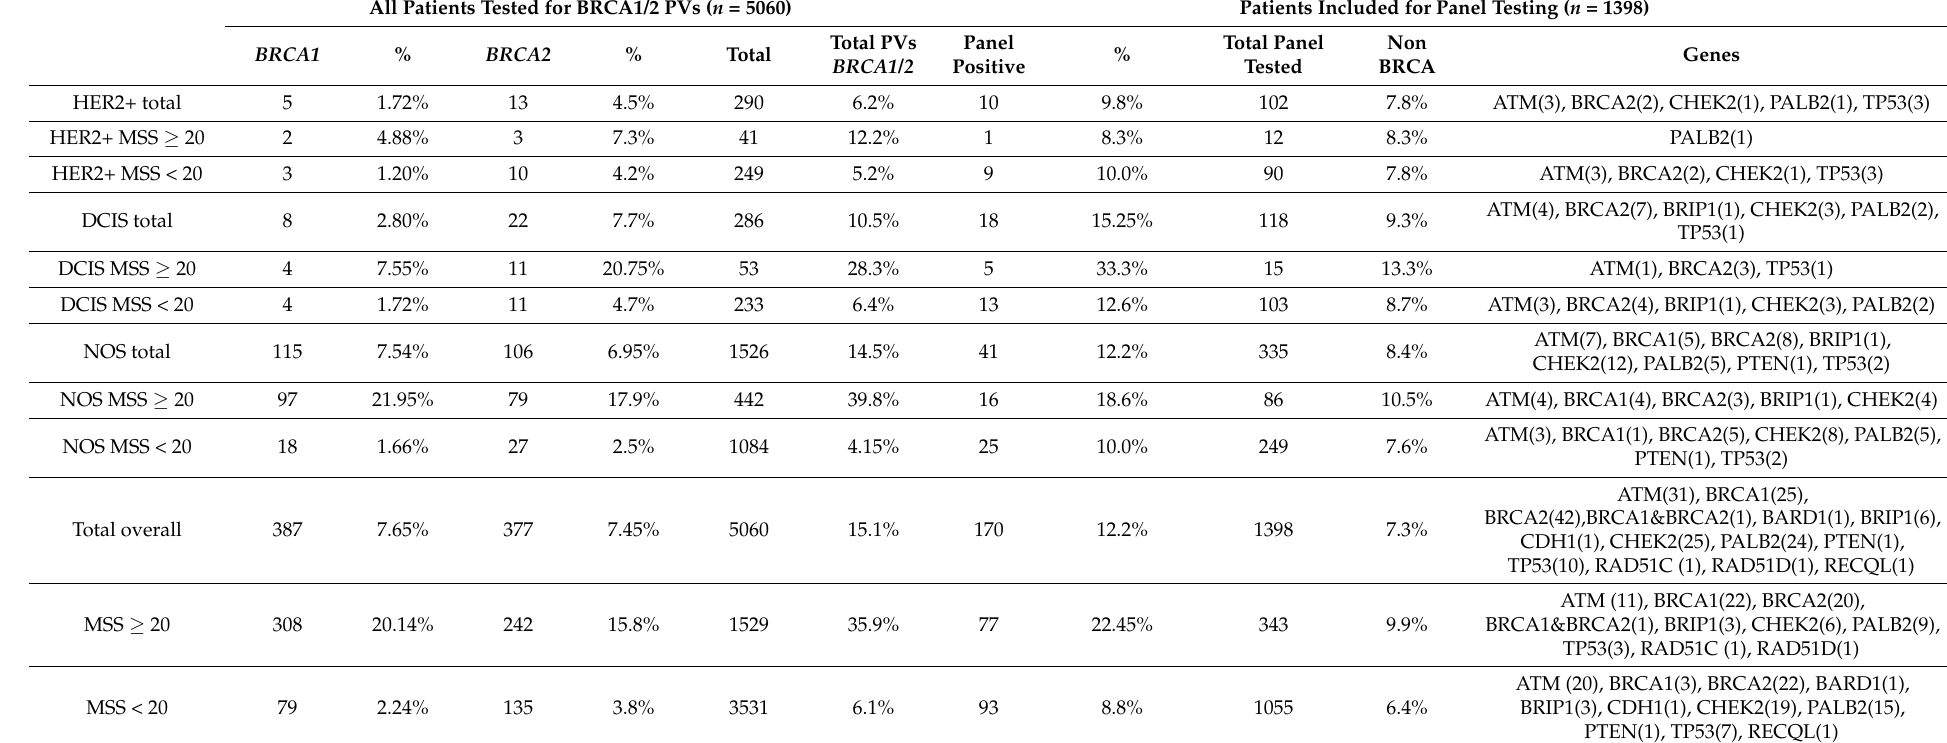
All Patients Tested for BRCA1/2 PVs ( n =